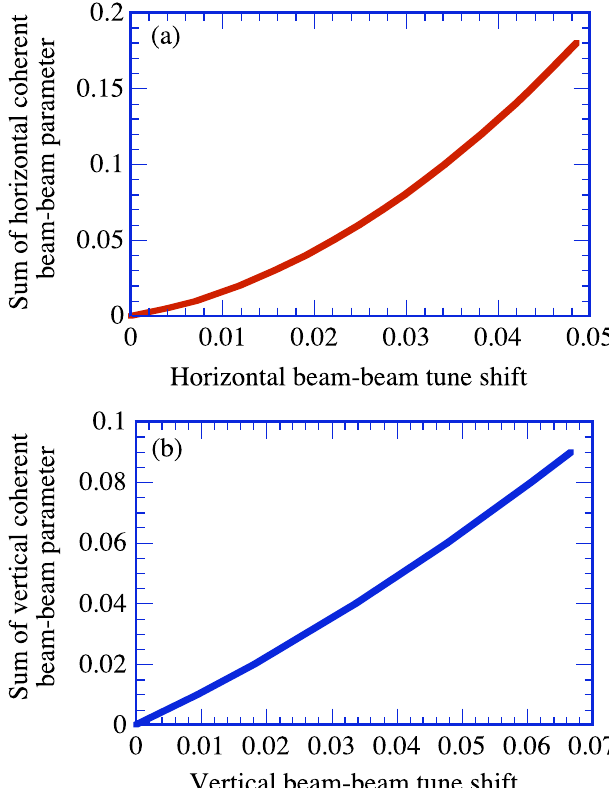
FIG. 2. (Color) Sum of coherent beam-beam parameters as a function of the coherent beam-beam tune shift. Part (a) shows the horizontal plane calculated with unperturbed fractional tunes ¼ 0 : 506 and (cid:5) (cid:3) ¼ 0 : 512 , and (b) shows the vertical plane (cid:5) þ x 0 x 0 calculated with unperturbed fractional tunes (cid:5) þ y 0 ¼ 0 : 571